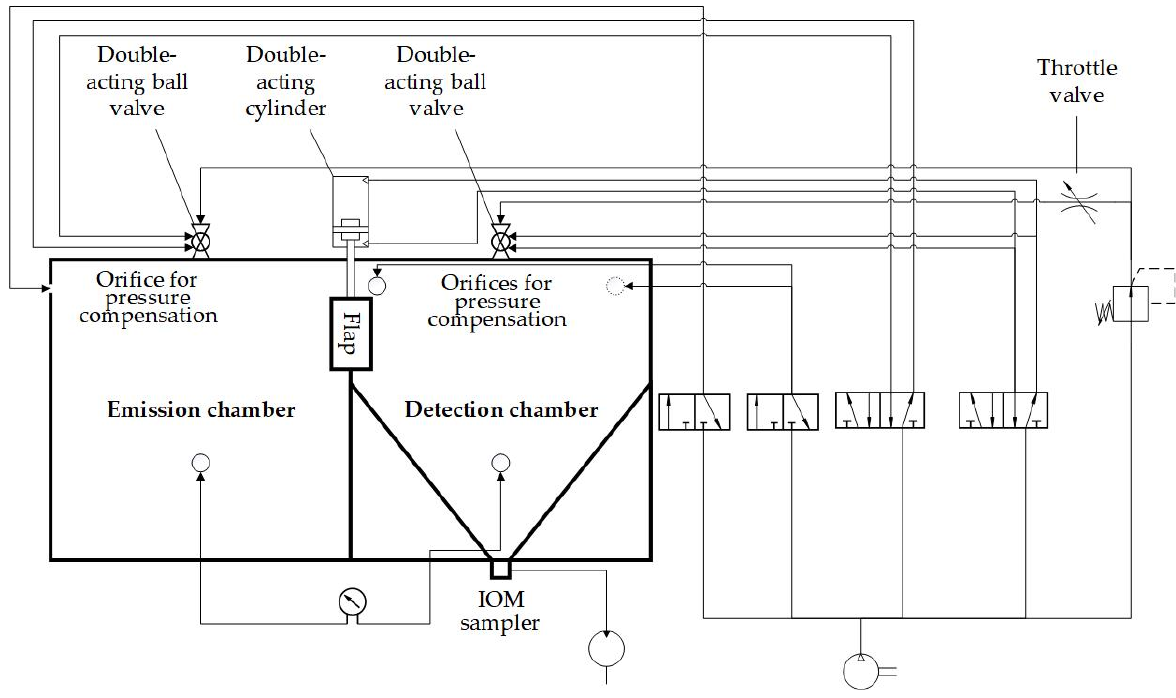
Figure 3. Piping and instrumentation diagram of the TCS.